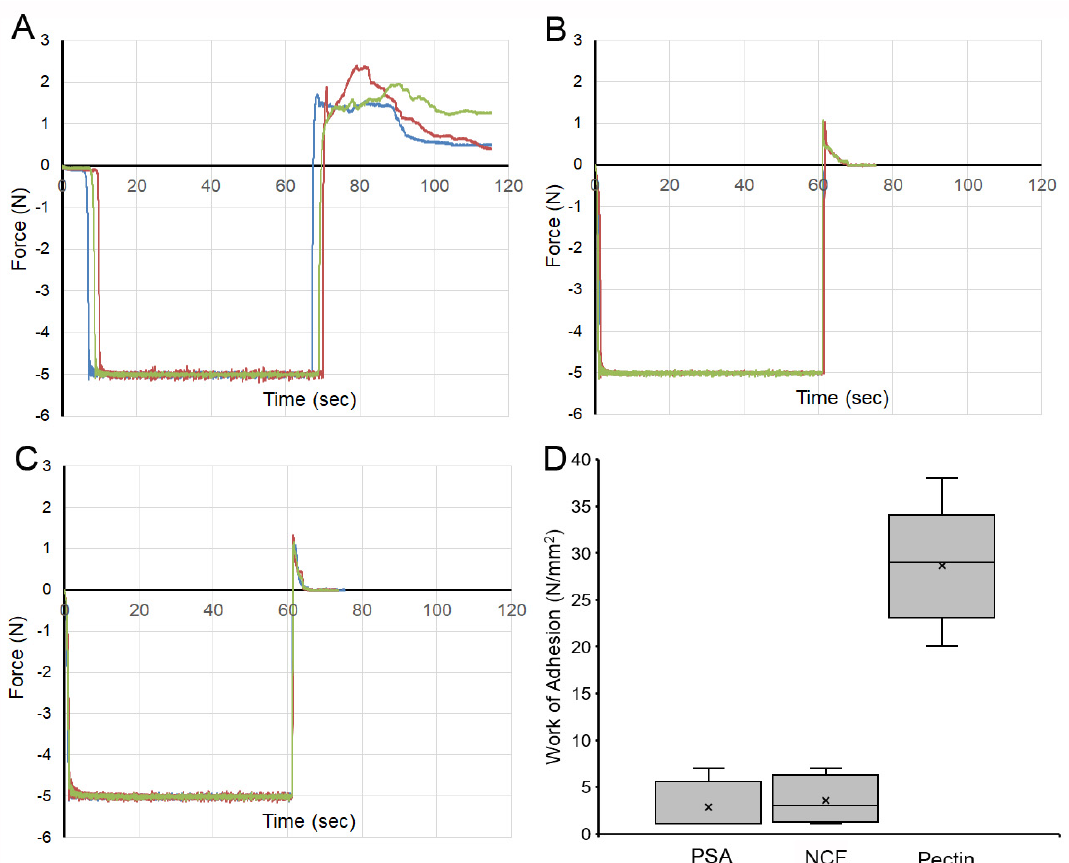
Figure 4. Comparison of the adhesion strength of pectin, nanocellulose fibers (NCF), and pressure-sensitive adhesive (PSA) to the porcine visceral pleura. In each condition, the pleural interface was compressed by the probe at 5N pressure for 60 s. The force required for probe withdrawal at 0.5 mm/s was recorded at 500 pps. ( A ) Pectin films and representative force tracings of probe withdrawal. NCF films ( B ) and PSA ( C ) demonstrate lower peak adhesion and rapid adhesion failure. ( D ) The work of adhesion, defined as the area under the force–distance curve, demonstrated a significant increase for pectin compared to NCF and PSA ( p < 0.001). The box spans the interquartile range with the median marked with an X and the whiskers defining the data range.